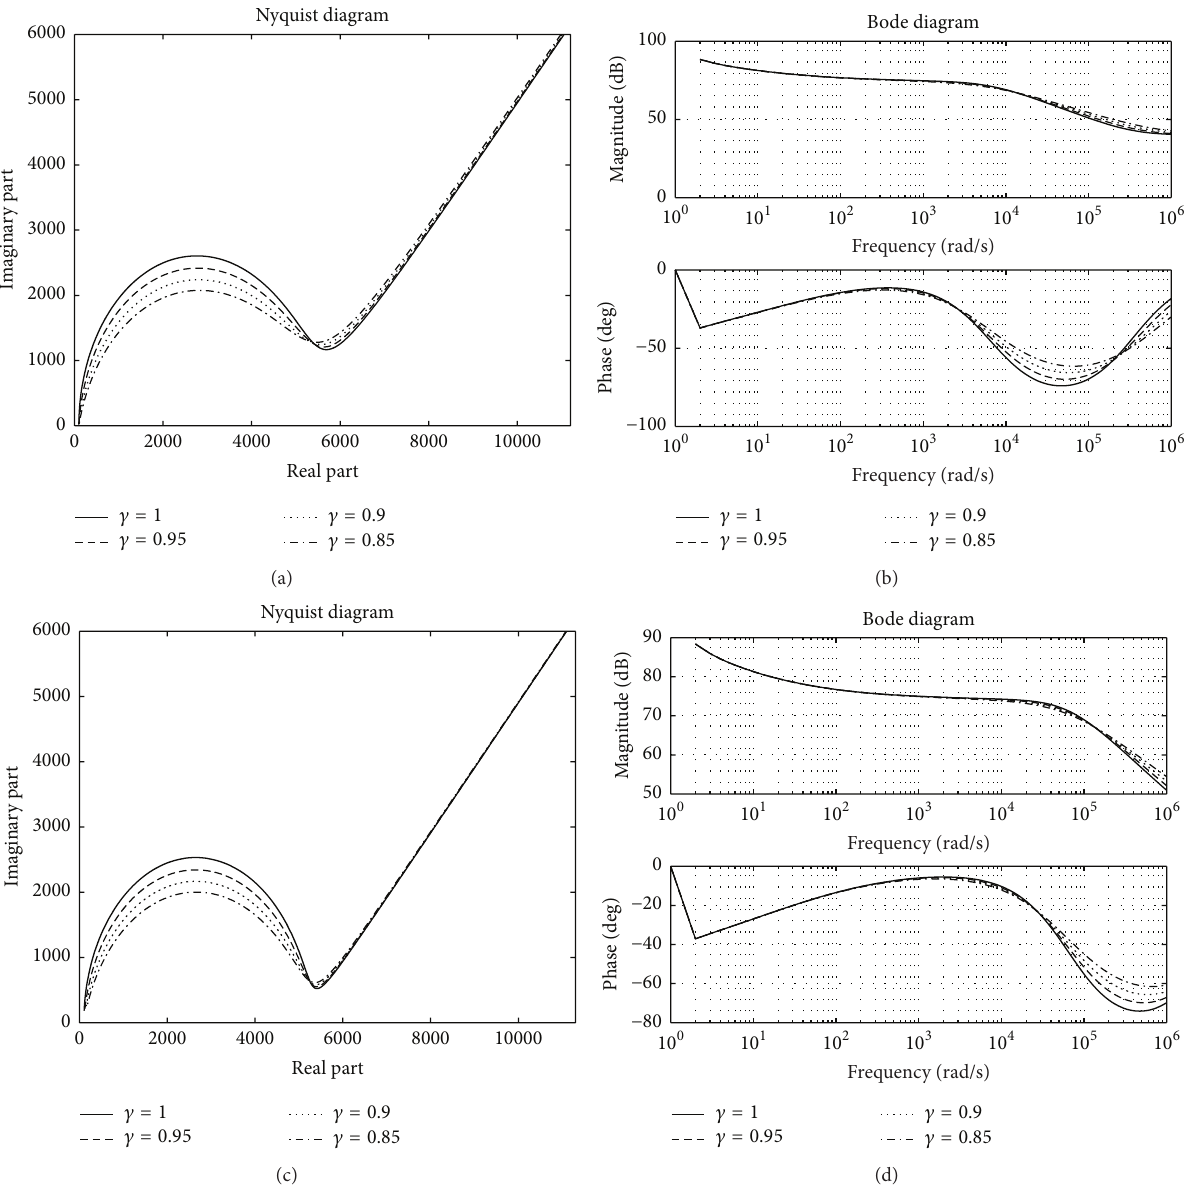
Figure 9: Nyquist and Bode diagram for the limited diffusion model, Caputo derivative approach, in (a) and (b): 𝑅 𝑠 = 100 Ω , 𝑅 𝑝 = 5000 Ω , = 3 −6 F, and 𝐶 = 1 −3 F for 𝛽 = 1/2 corresponding to 𝐶 𝐶 𝑠 𝑝 and 𝐶 𝑝 = 1 −3 F for 𝛽 = 0.4 corresponding to 𝐶 𝑠 , 𝛾 = 1 , 𝛾 = 0.95 , 𝛾 = 0.9 , and 𝛾 = 0.85